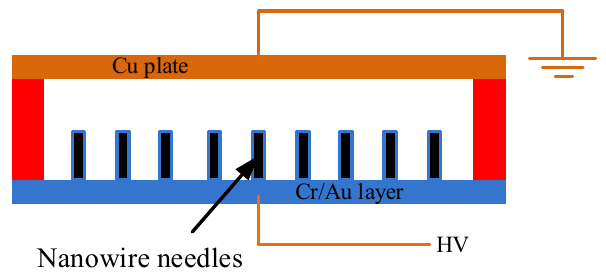
Figure 8. Schematic diagram of a discharger using nanowires as anodes.